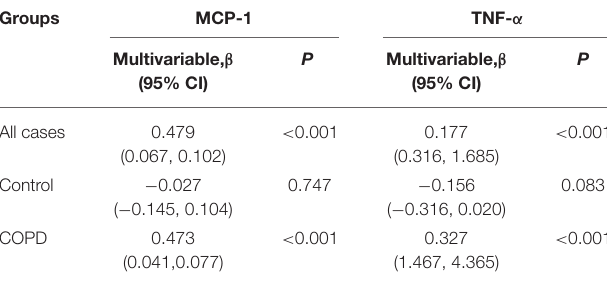
TABLE 4 | Association of serum CYR61 and hospital stays in COPD patients.